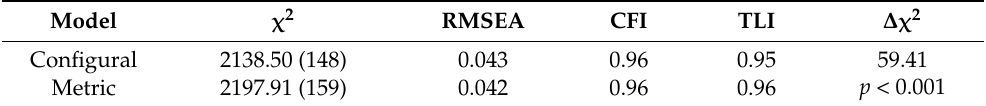
Table 3. Results of measurement invariance testing in the modified MHC-SF factor